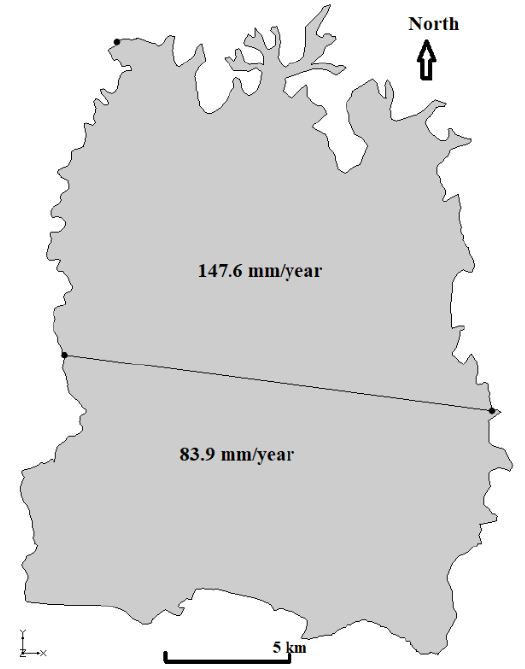
Figure 6. Map showing the two recharge polygons used to estimate the average recharge over the entire lower Rusizi plain.